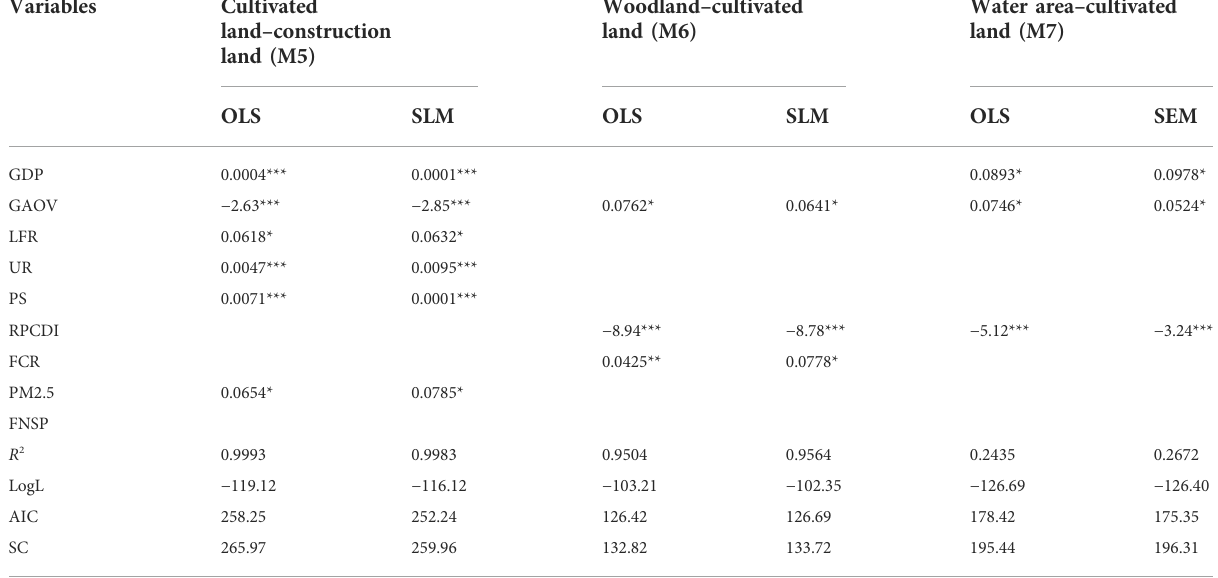
TABLE 7 Factors in fl uencing land use transitions in the study area, 2010 – 2018.